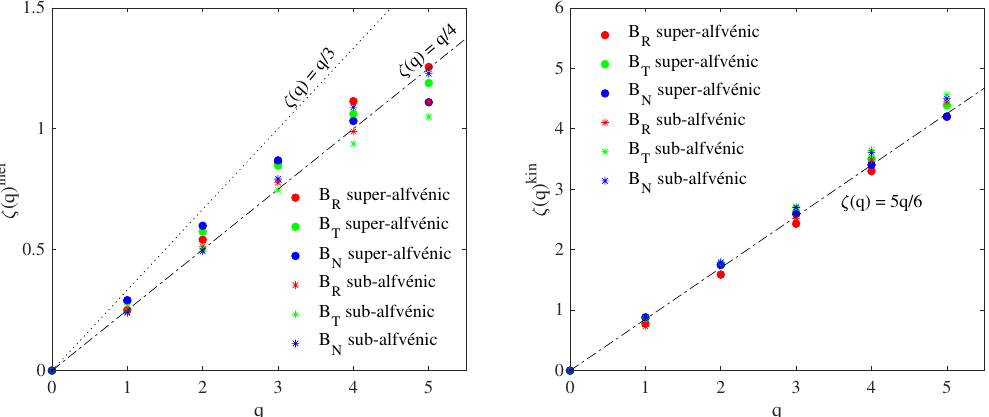
Figure 4. The scaling exponents ζ ( q ) derived via ESS analysis for each magnetic field component ( B R : red symbols, B T : green symbols, B N : blue symbols) during both the super-alfvénic (circles) and the sub-alfvénic (asterisks) intervals: inertial range (left panel) and sub-ion/kinetic range (right panel). The dashed-dotted and the dotted lines in the left panel refer to the Iroshnikov-Kraichnan ζ ( q ) = q /4 and the Kolmogorov ζ ( q ) = q /3 predictions. The dashed–dotted line in the right panel is used as a reference for linear